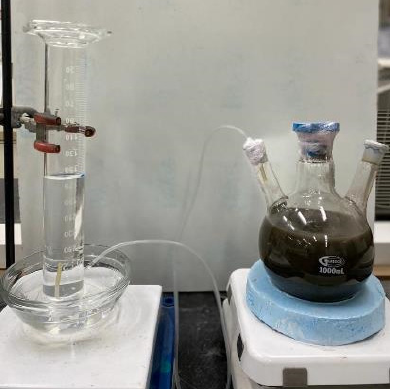
Figure 2. Experimental setup of quantification of metallic aluminum in MIBA.